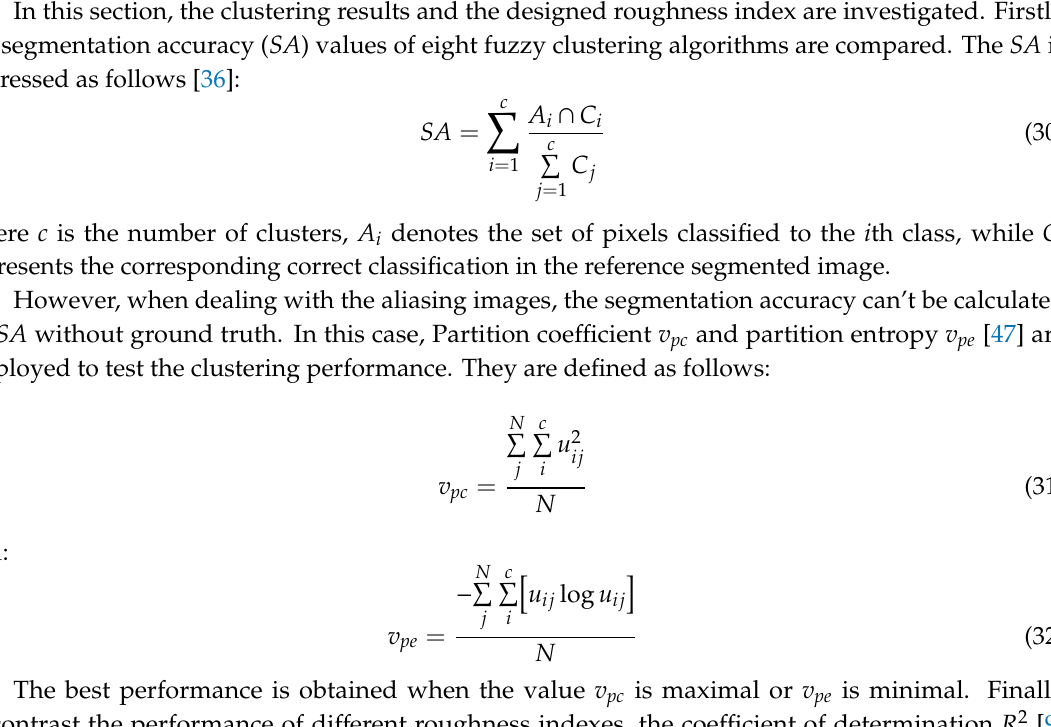
Figure 6. Aliasing images (the roughness is 0.0392, 0.1697, 0.2964, 0.4261 μm, respectively). ( a ) 0.0392 Figure6. Aliasingimages(theroughnessis0.0392, 0.1697, 0.2964, 0.4261 µ m, respectively). ( a )0.0392 µ m, μm , ( b ) 0.1697 μm , ( c ) 0.2964 μm , ( d ) 0.4261 μm . ( b ) 0.1697 µ m, ( c ) 0.2964 µ m, ( d ) 0.4261 µ